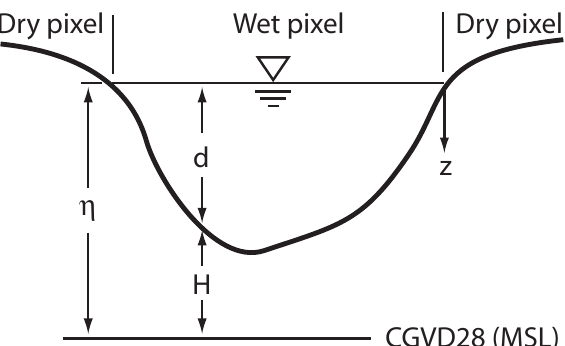
Figure 2. Diagram of flow depth ( z = d ) below the water surface and riverbed elevation, H , above a vertical datum; P is a point at the bed.